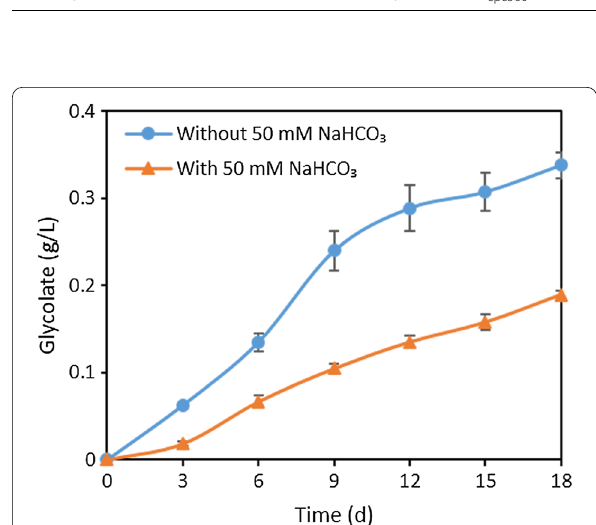
Fig. 2 Glycolate production by strain WT-ΔglcD with or without supply of 50 mM NaHCO 3 . The cells were cultivated at 30 o C under 100 µmol photons m − 2 s − 1 light intensity. Error bars represent standard deviations from biological triplicates conducted in three independent